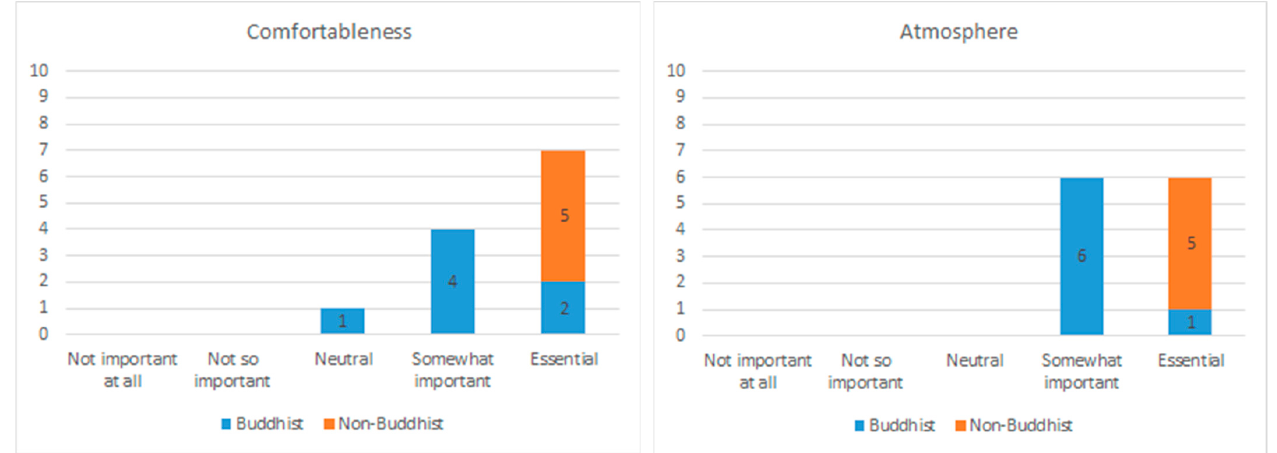
Figure 9. Results from responses to the question: “Please rate how important each of these physical elements is to you, as a means of supporting your practice and your intention to be mindful”.